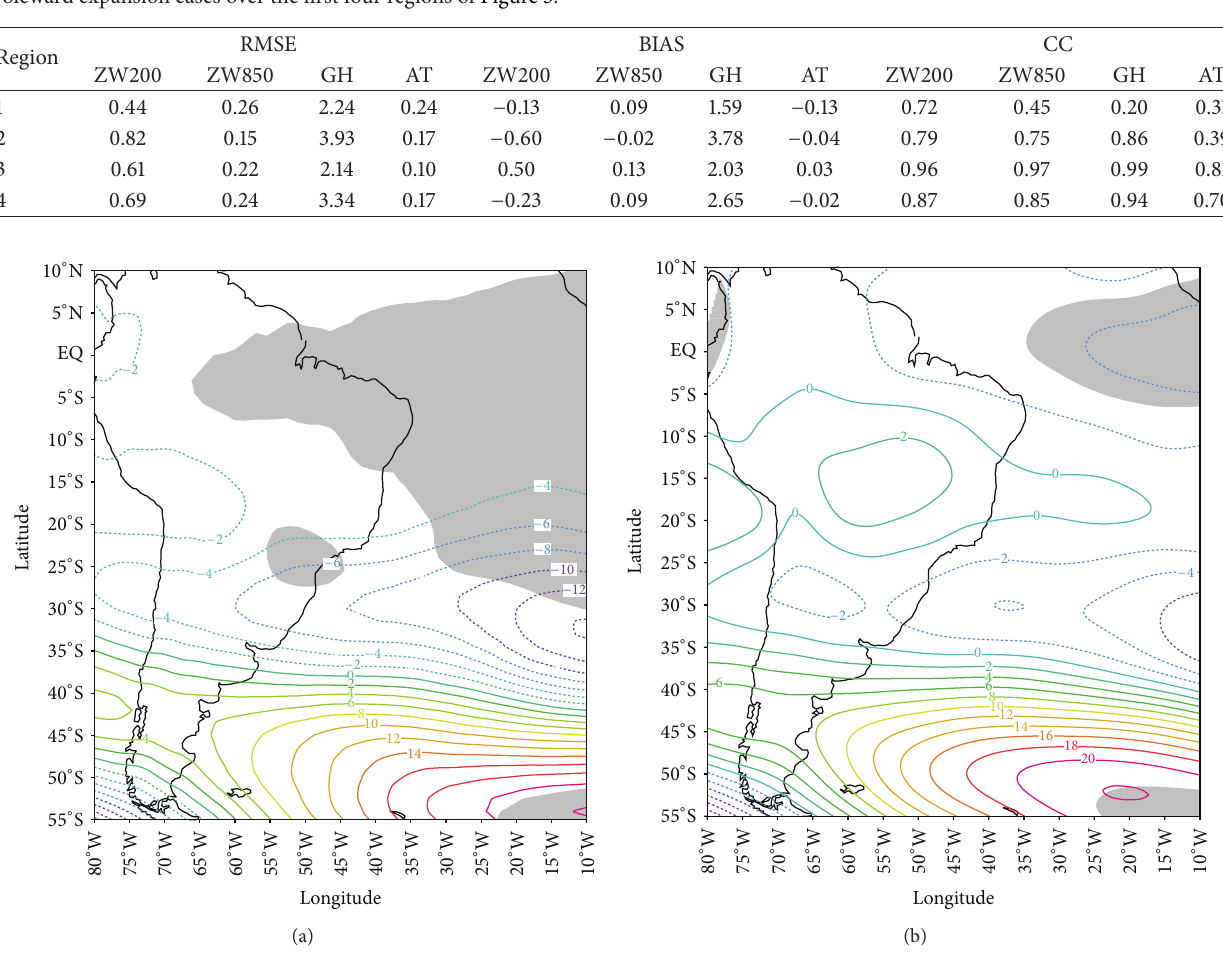
Figure 15: Annual mean geopotential height (m) anomaly for HCSA strong cases at 500 hPa in the period 1996–2011 based on the (a) Era- Interim reanalysis and (b) RegCM4 simulation. Contour intervals are 2m and significant values above 90% confidence level from two-tailed Student’s 𝑡 -test are